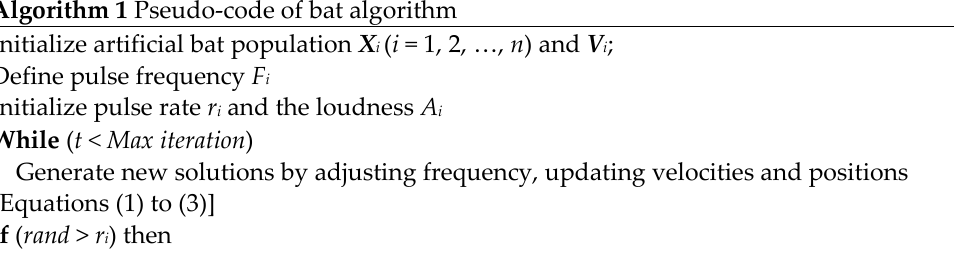
Algorithm 1 Pseudo-code of bat